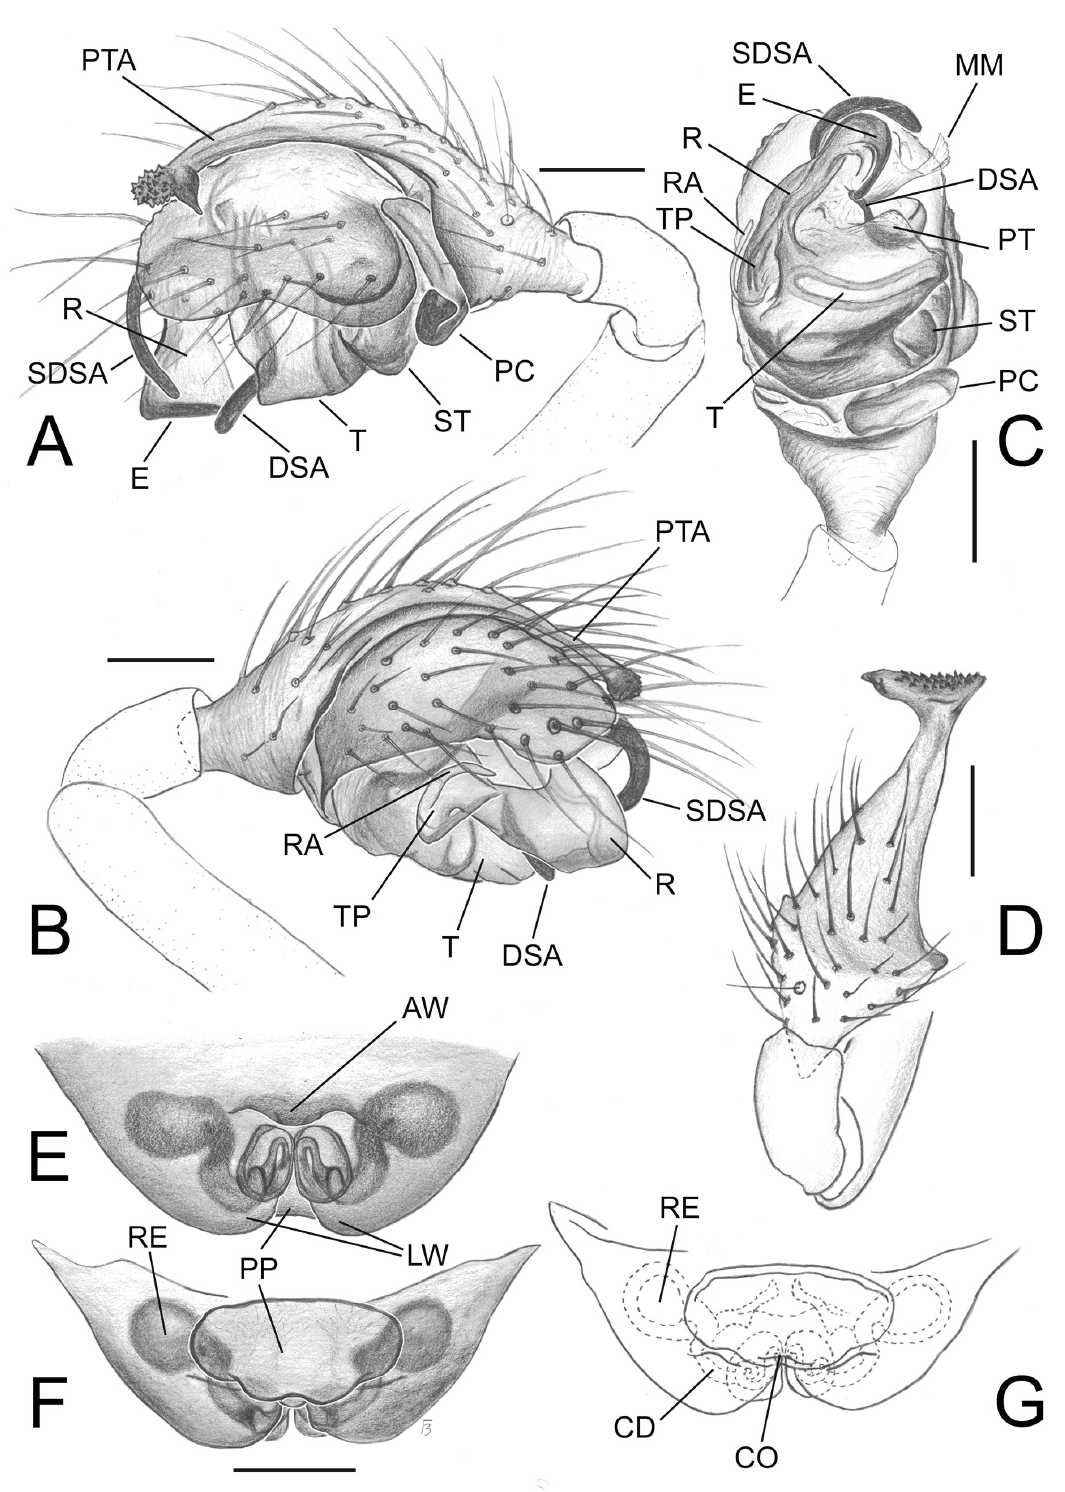
Fig. 3. Nihonella chika gen. et. sp. nov. A . ♂, holotype (NSMT-Ar 20909), palp, retrolateral view. B . Ditto, prolateral view. C . Ditto, ventral view. D . Ditto, palpal tibia, dorsal view. E . ♀, paratype (NSMT- Ar 20910), epigyne, ventral view. F . Ditto, dorsal view. G . Ditto, vulva, dorsal view. Abbreviations: see Material and methods. Scale bar = 0.1